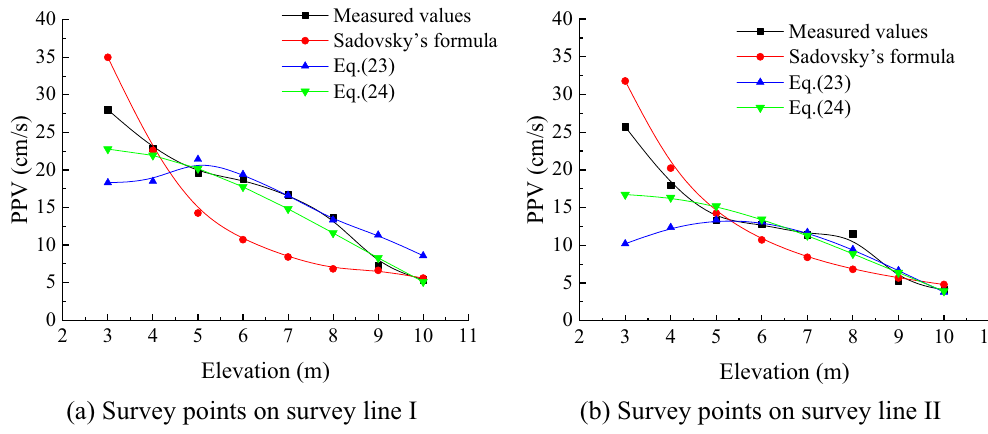
Figure 12. Comparative analysis of PPV at different